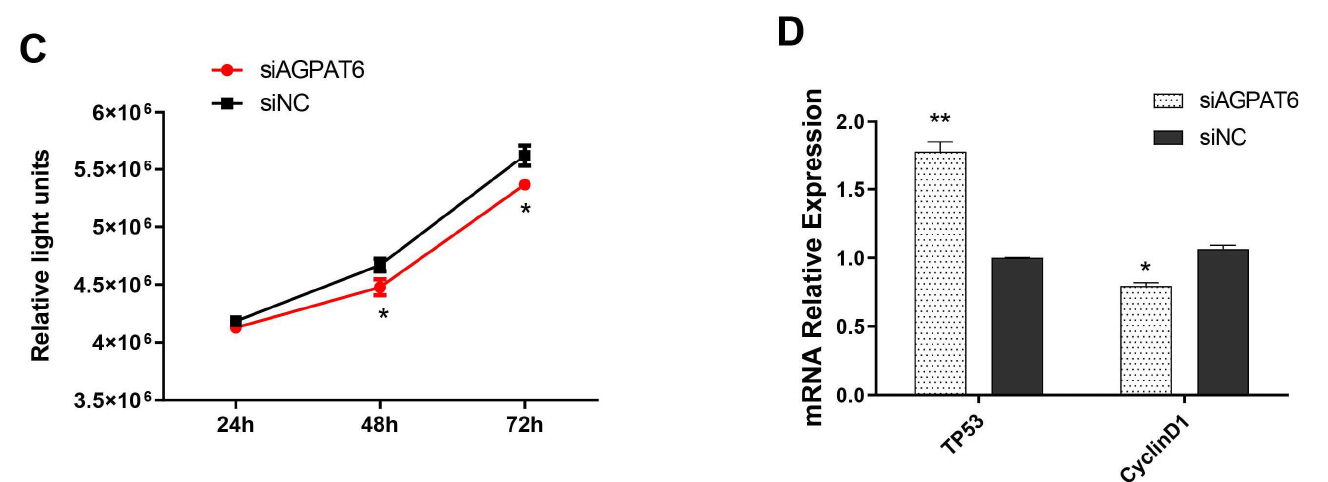
Figure 4. AGPAT1 and AGPAT6 induced cell proliferation of BuMECs. ( A ) Effect of AGPAT1 knock- down on BuMECs by the CCK-8 detection; ( B ) effect of AGPAT1 knockdown on proliferation-re- lated gene expression; ( C ) Effect of AGPAT6 knockdown on BuMECs by the CCK-8 detection; ( D )